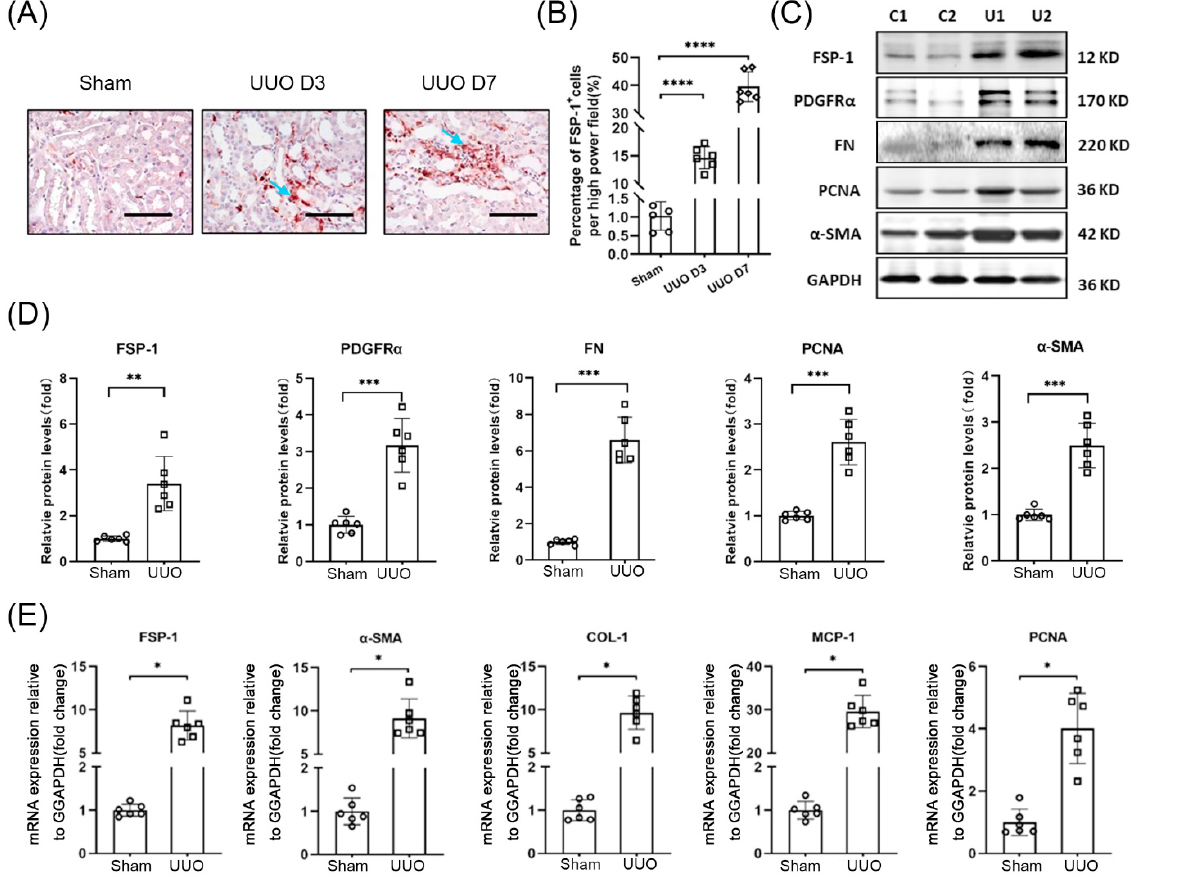
Figure 1. FSP-1 positive cells accumulate in UUO. ( A , B ). The presence of FSP-1 + cells was deter- mined by immunostaining in kidneys after UUO on day 3 and day 7. Positive cells (FSP-1 + ) were indicated by arrows ( A ) and quantified ( B ) (****, p < 0.0001 vs. Sham; bar = 50 μm). ( C , D ). The expression and densitometric analysis of the indicated markers in control and obstructed kidneys (**, p < 0.005; ***, p < 0.001). ( E ). Real-time RT-PCR analysis of the expression of indicated molecules. Relative mRNA levels were shown after normalization with GAPDH. (*, p < 0.05). C, sham controls; U, UUO kidney; GAPDH, glyceraldehyde-3-phosphate dehydrogenase; PDGFR, platelet-derived growth factor receptor; SMA, smooth muscle actin; FN, fibronectin; PCNA, proliferative cell nuclear antigen. Data are expressed as mean ± SEM, n = 6 mice.